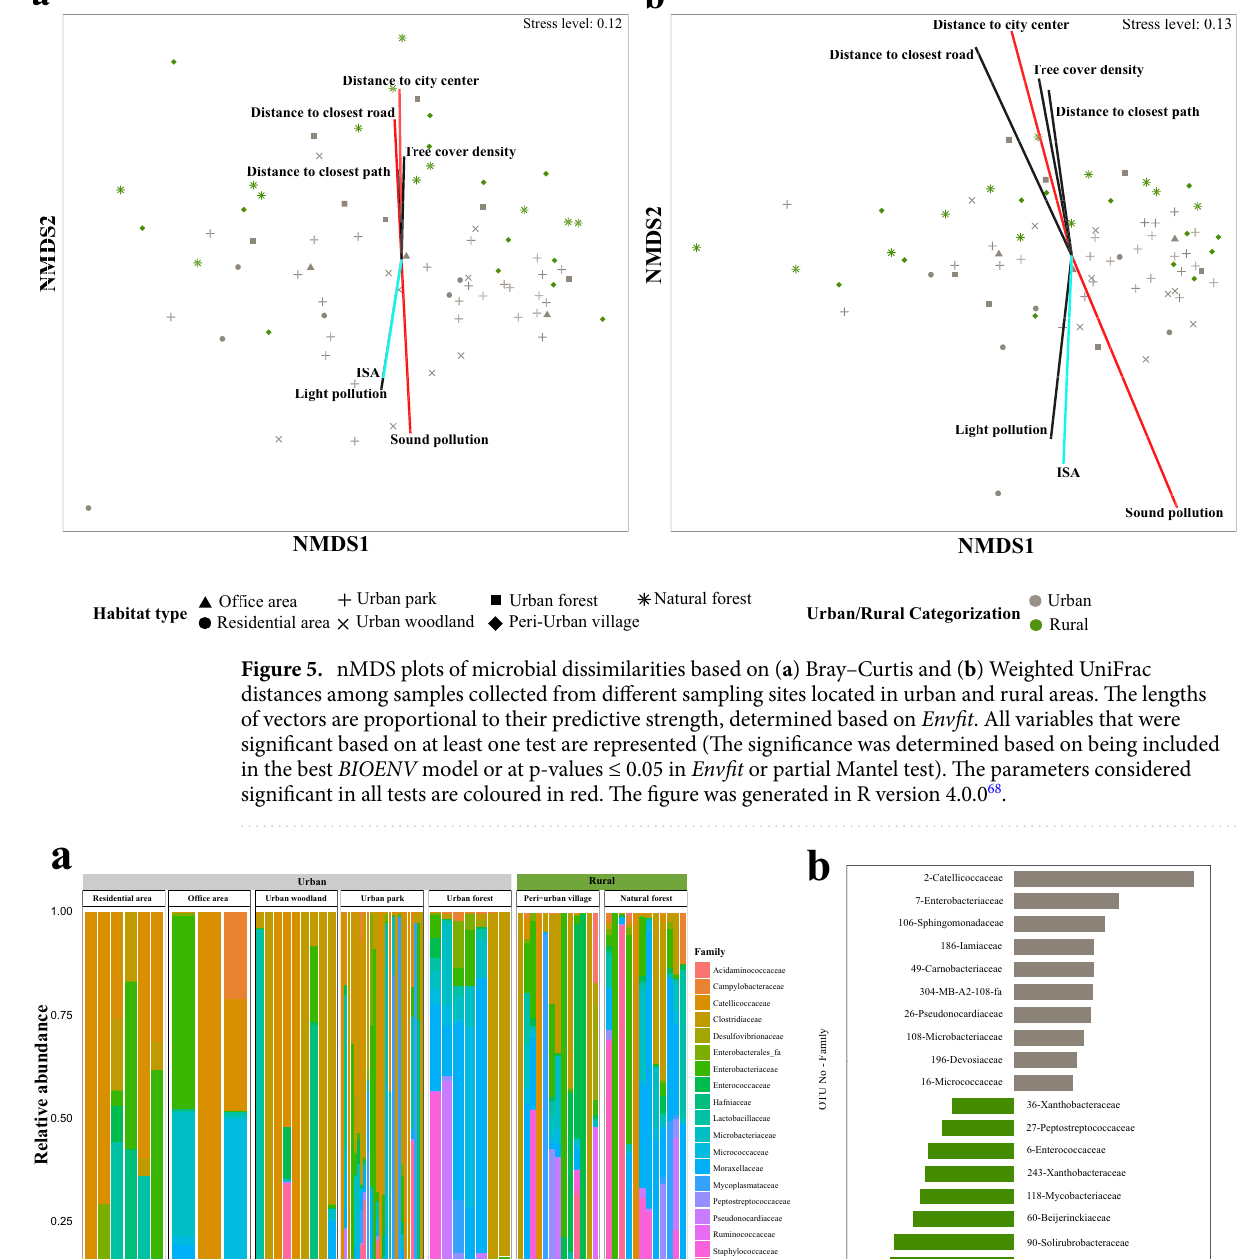
driven variation in gut microbiota. We applied a partial mantel test to investigate the correlations between micro- bial dissimilarity matrices and the distance matrices of the environmental variables, controlling for the effect of the distance matrix of the geographical coordinates of the sampling sites. We found that sound pollution, distance